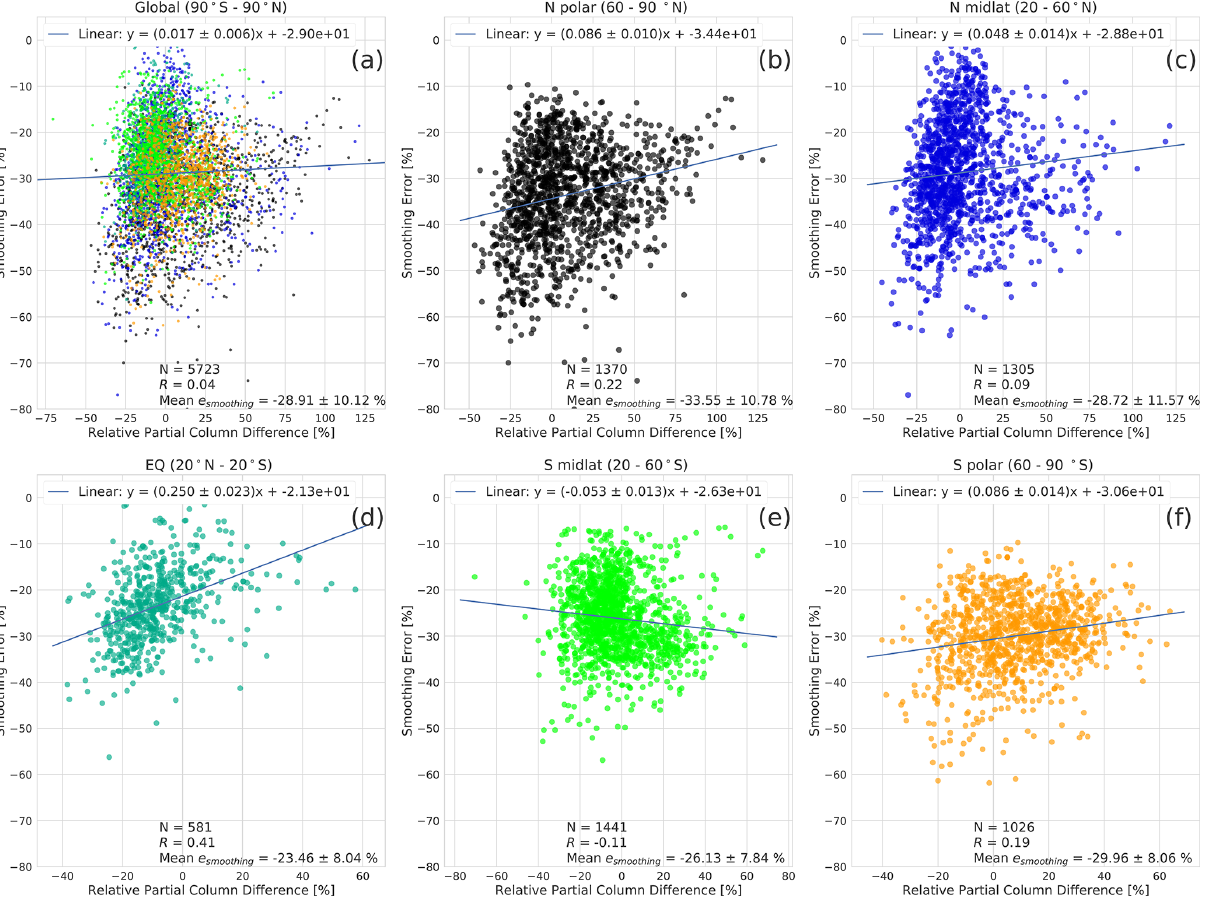
Figure 7. Correlation plots of the relative smoothing error of the TROPOMI retrievals for cloudy scenes versus the relative partial column differences between ACE-FTS and TROPOMI in the same latitude bins as Fig. 2. See the caption of Fig. 2 for more details.